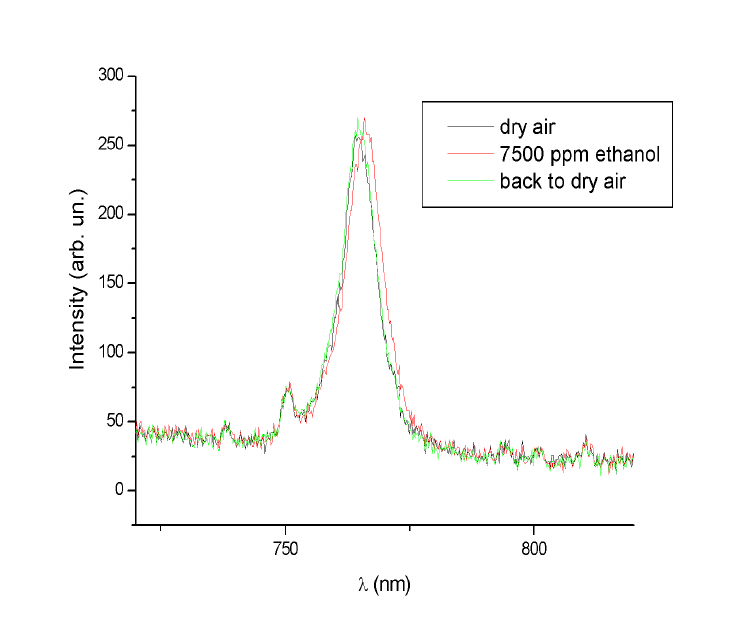
Figure 4. PL spectra of p + PSM, under controlled flux of air containing ethanol, at RT. Spectra have been acquired 10 minutes after the switching of the flux with the indicated